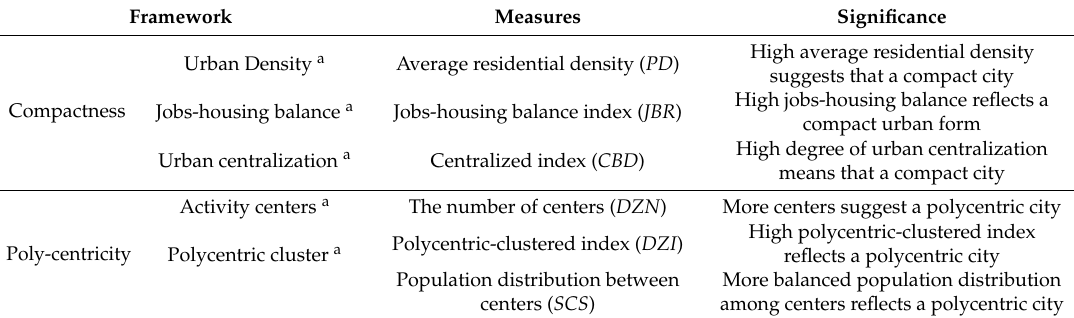
Table 1. The descriptions of compactness and poly-centricity